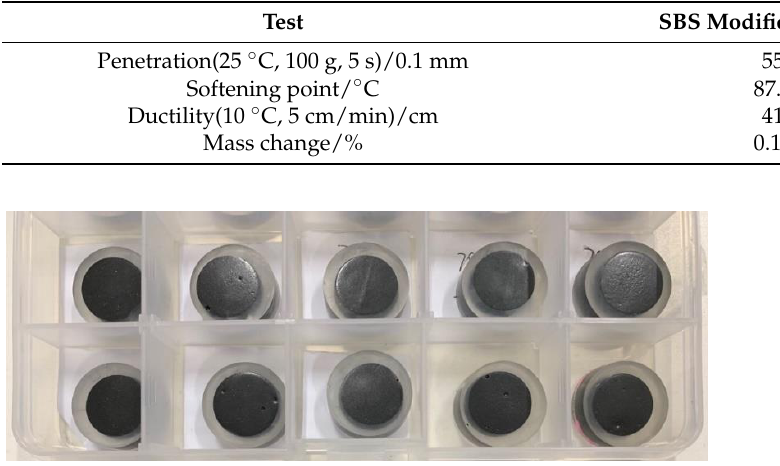
Table 2. Properties of SBS modified asphalt.